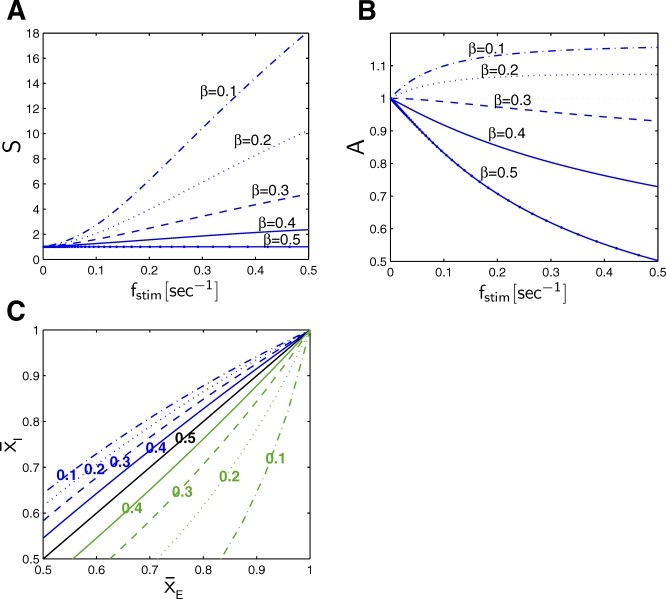
Selective Adaptation in the Theoretical Model(A) Selectivity as defined in Equation 13, for a selective adaptation paradigm using the sigmoidal activity function given in Equation 12 (parameter values as in Figure 3). Here we also assume ρ
0 = 2. Selectivity is monotonically increasing in f
stim and decreasing in β.(B) Amplification as defined in Equation 14, for the same paradigm. For high values of β (here, for β = 0.5, 0.4, and 0.3) amplification is decreasing with stimulation frequency and is below 1 (i.e., the response to the rare is in fact depressed). When β is further decreased (here, for β = 0.2 and 0.1), amplification becomes non-decreasing and above 1 so that the response is indeed amplified.(C) phase plane loci of fixed points for the rare (green) and frequent (blue) sites for different values of β (marked on the curves). Note that for each value of β, ρ
0 = ρrare + ρfreq so that when the locus curve of the rare shifts towards the lower right corner (i.e., towards amplification) the locus curve of the frequent shifts towards the upper left corner (i.e., towards stronger depression).